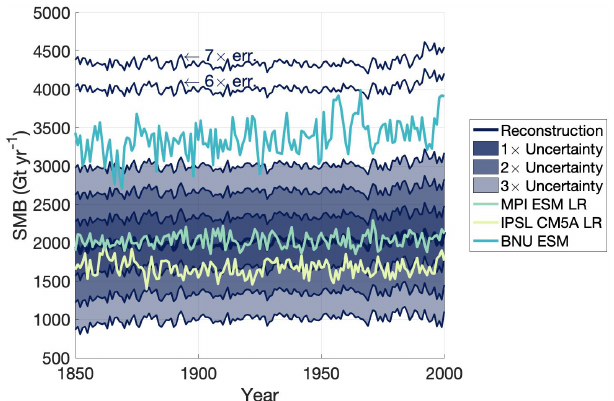
Figure 1. Time series of the reconstructed AIS-integrated SMB time series (dark indigo) with 1 × , 2 × , and 3 × the uncertainty in dark indigo, medium indigo, and light indigo, respectively. Three model AIS-integrated SMB time series, MPI ESM LR (green), IPSL CM5A LR (yellow), and BNU ESM (cyan) have been plotted as well to demonstrate different model scoring. MPI ESM LR is en- tirely captured within 1 × the total uncertainty and, thus, receives a score of 1. IPSL CM5A LR is entirely captured within 2 × the uncertainty so its score for this criterion is 2. BNU ESM is fully captured within 7 × the